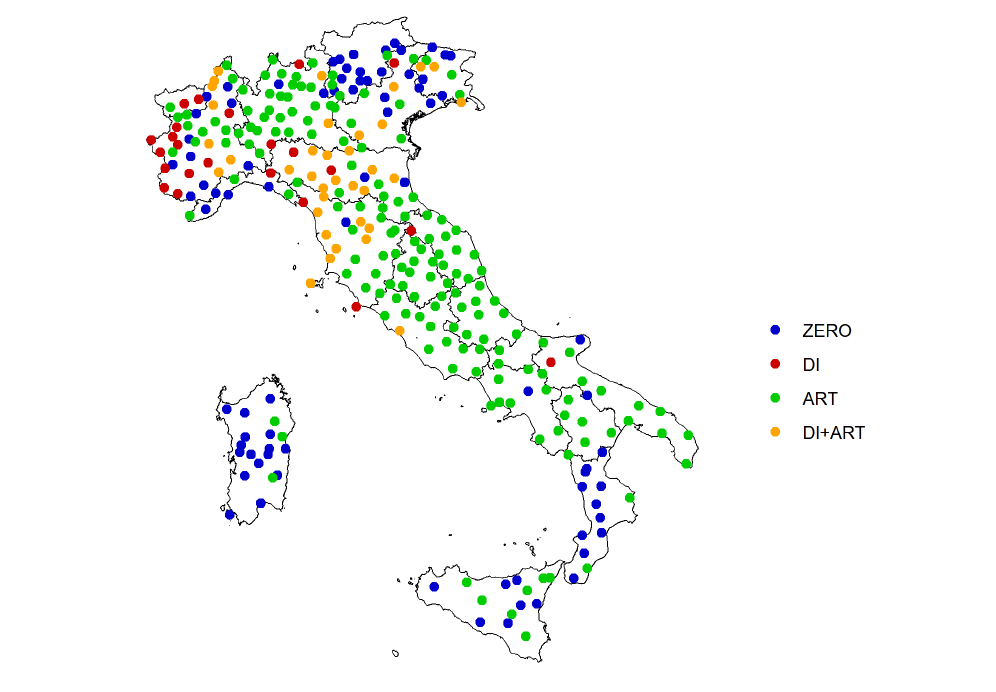
Figure 3. Rendering of the AIS map number 637, showing the distribution of the use of the four determiners in the sentence “[to go look for] violets”